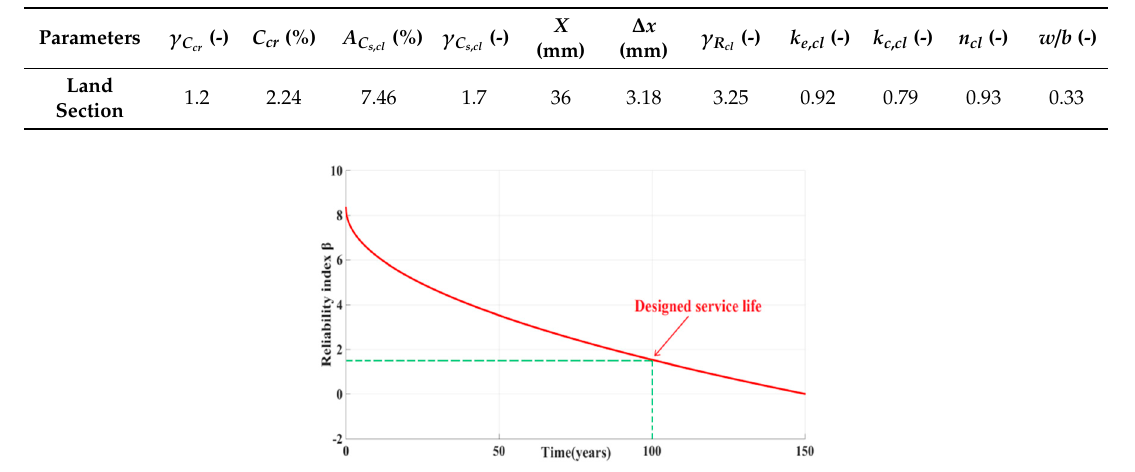
Table 12. Parameters used in the revised DuraCrete model in the land section.